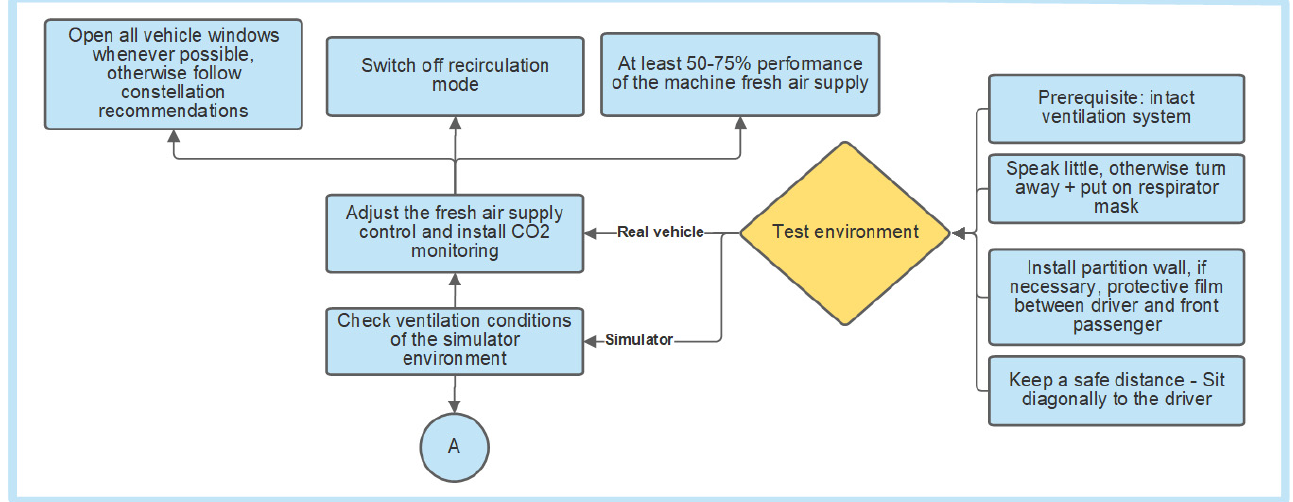
Figure 7. Infection control measures in vehicles and simulators.